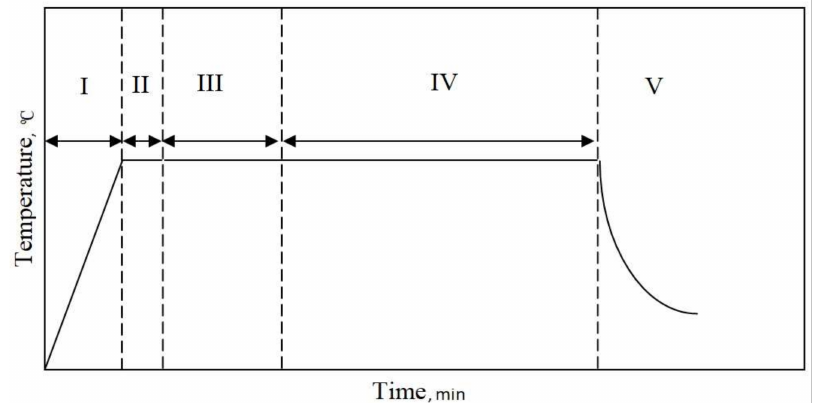
Figure 2. Temperature profile of the Zr + Al CVD deposition process. The coatings’ microstructure was analyzed using the scanning electron microscope (SEM) equipped with the energy dispersive spectroscope (EDS), electron backscattered diffraction (EBSD), and X-ray diffraction (XRD) methods. Parameters of the CVD process were carefully chosen on the basis of previous experiments [28]. Oxidation tests were performed at 1100 ◦ C, a little bit higher than the operating temperature of coated parts, e.g., blades of an aircraft engine. The exposure time is long enough to notice the coating’s degradation. The atmosphere is the same in which coated blades